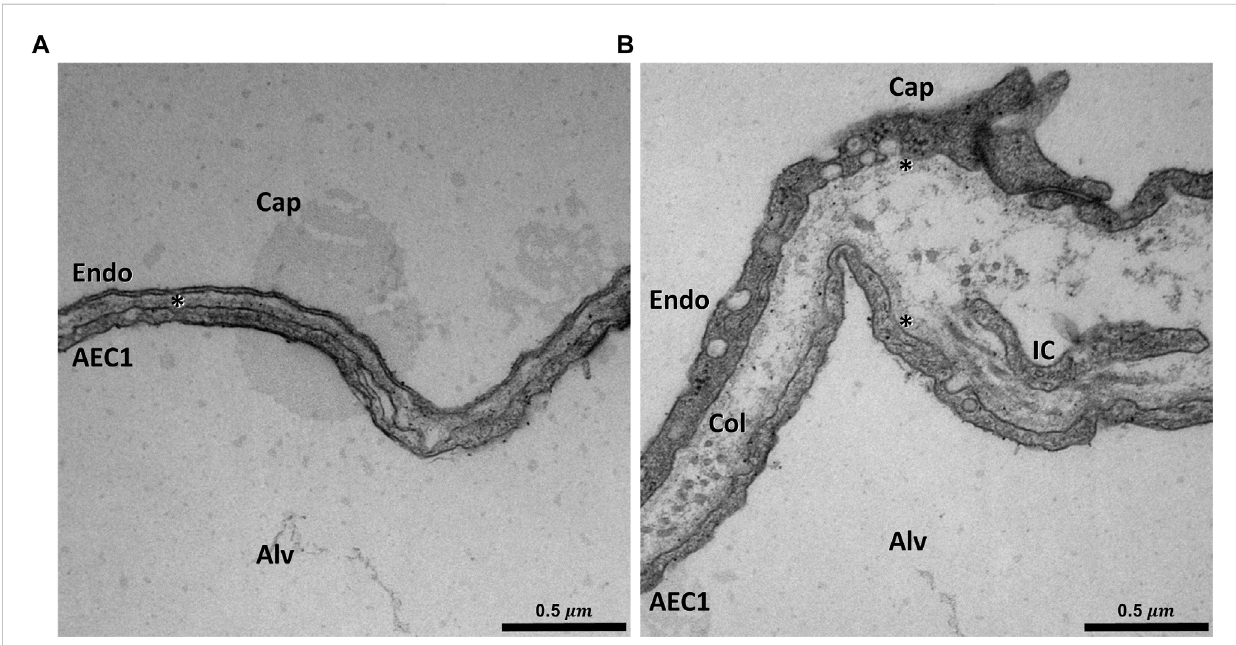
FIGURE 1 Ultrastructure of the blood-gas barrier: Transmission electron micrograph of a rat lung fi xed in vivo by vascular perfusion via the vena cava caudalis at an airway opening pressure of5 cmH 2 O on expiration after two recruitmentmaneuvers (3 spause at30 cmH 2 O) (Knudsen etal., 2018). The capillaries (Cap)areopenandfreefrombloodcells.In (A) anexampleofthethinpartoftheblood-gasbarriercanbeseen.Inthisareathesquamousextensionofan alveolar epithelial type1 cell (ACE1), thebasement membrane (asterisk)and theendothelialcell (Endo) form theblood-gas barrier.In (B) an example of the thick part of the blood-gas barrier is illustrated. The interstitium between the AEC1 and the endothelium is widened and both AEC1 and the endothelialcellhaveabasementmembrane(asterisk)ofitsown.Asidefromcollagen fi brils(Col),cellextensionsofinterstitialcells(IC),e.g. fi broblastscan be identi fi